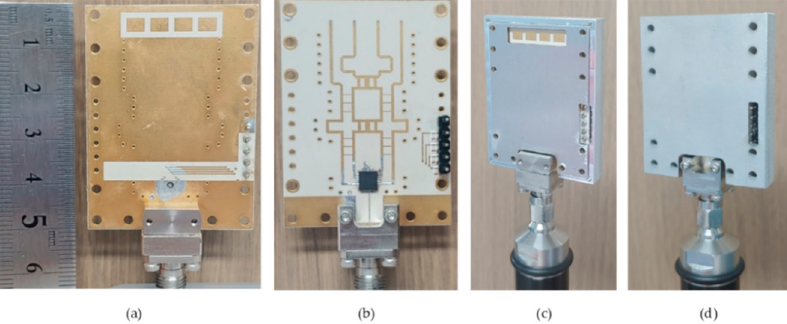
Figure 6. Photographs of the fabricated antenna. ( a ) Antenna side of PCB, ( b ) Butler matrix side of PCB, ( c ) antenna side of metal enclosure, ( d ) back side of metal enclosure.